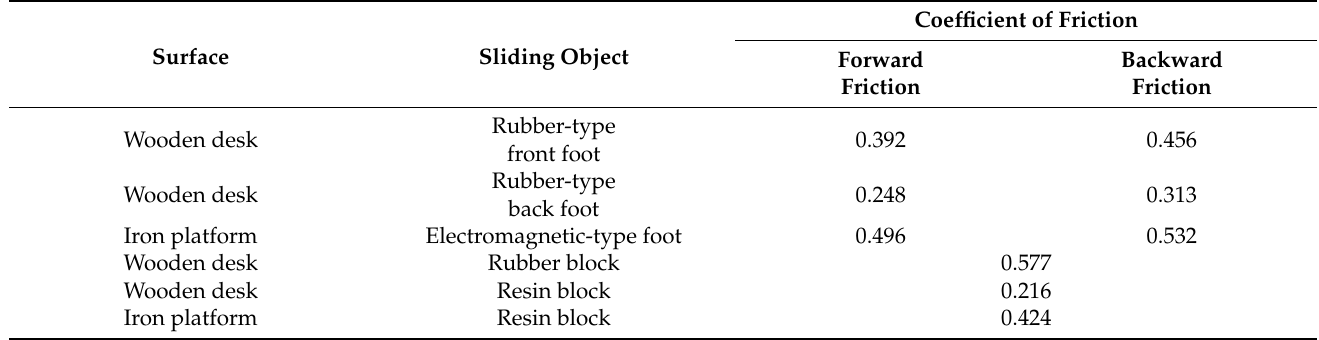
Figure 15. Setup of the sliding test between sliding feet and a frictional surface. Table 3. Coefficients of friction between different sliding feet and surfaces.